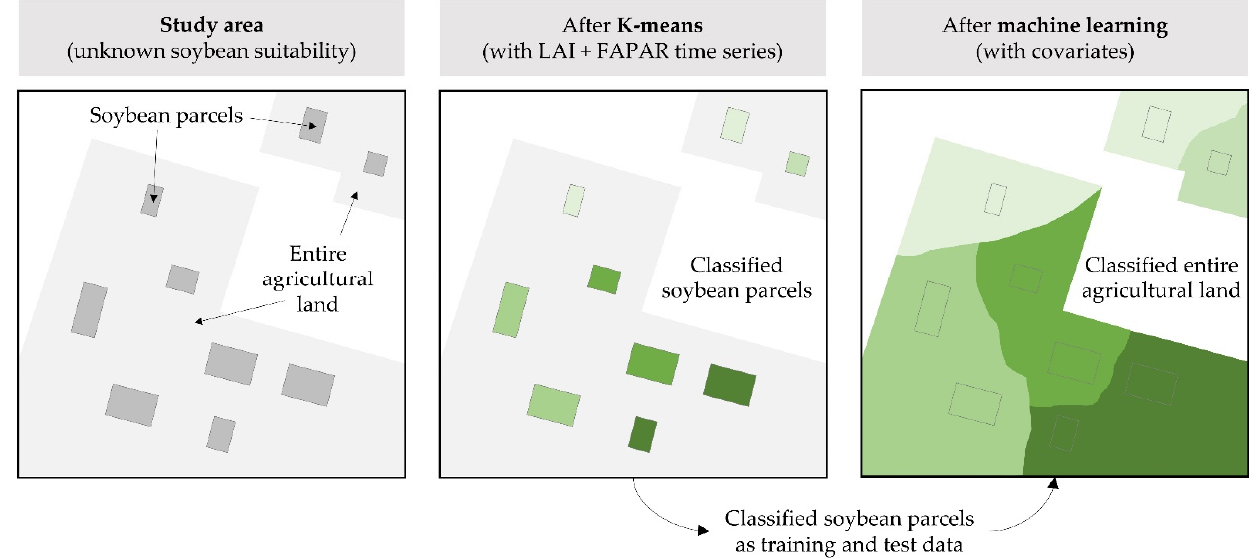
Figure 4. Two-step classification principle using K-means and machine learning for soybean cropland suitability assess- ment.